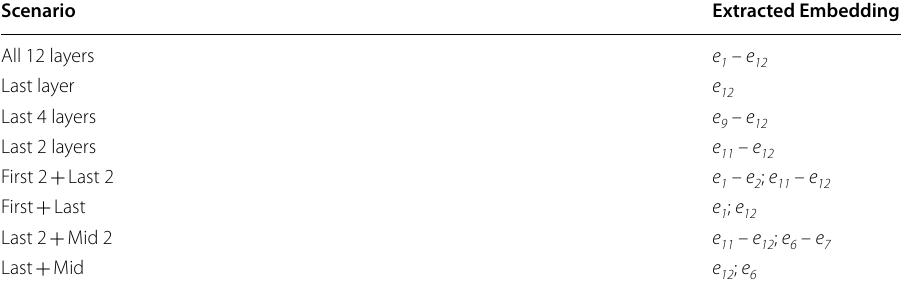
Table 3 BERTweet Embedding Extraction scenarios description Scenario